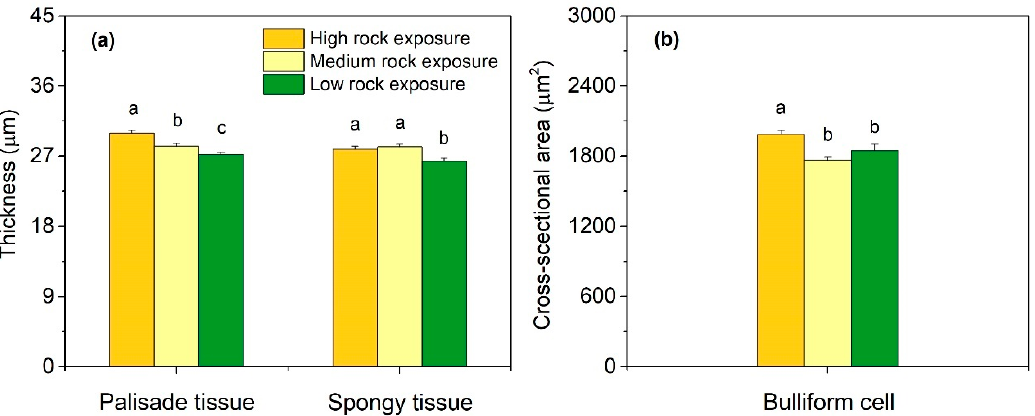
Figure 3. Mesophyll anatomical traits of Phyllostachys glauca from three habitats (high rock exposure, medium rock exposure, and low rock exposure) in the limestone mountain. ( a ), the thickness of palisade and spongy tissue; ( b ), the cross-sectional area of bulliform cell. Values are means ± S.E. ( n = 100). Lowercase letters that differ within an anatomical trait indicate significant ( p < 0.05) differ- ences among different habitats.